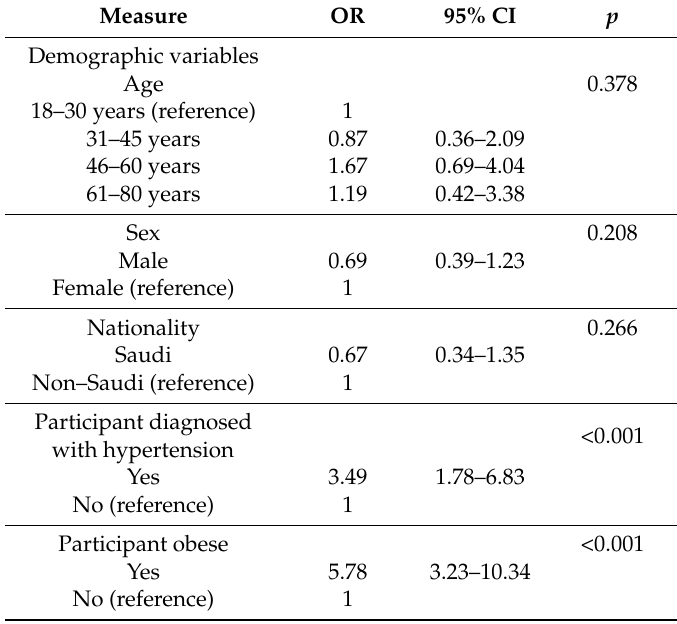
Table 2. Odds ratios and 95% confidence intervals for predictors of high risk for sleep apnea using the Berlin